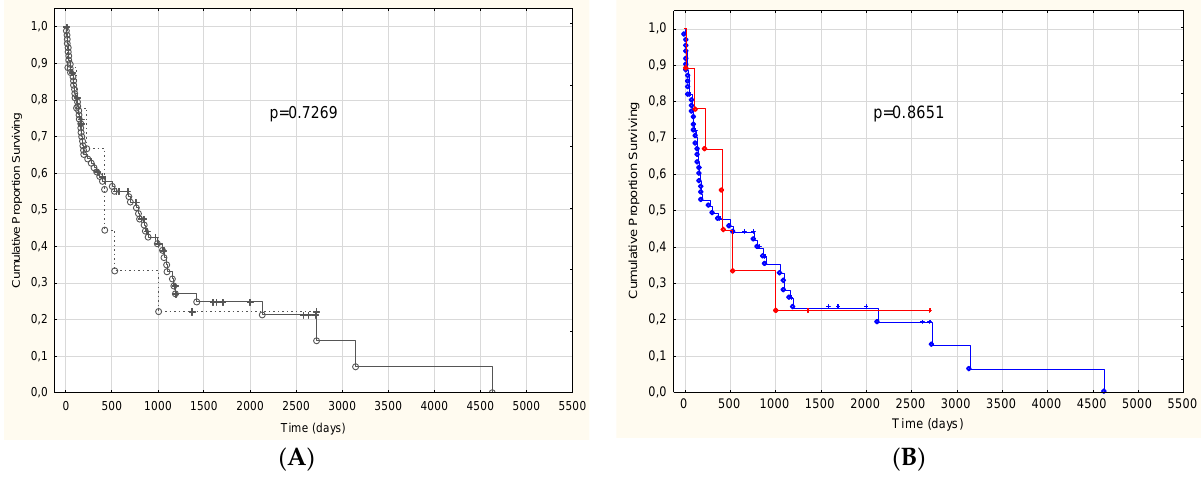
Figure 2. ( A ): Kaplan–Meier curves comparing cardiac amyloidosis patients with and without increased left ventricular wall thickness (IWT: n = 89, non IWT: 9; Log–Rank test: p = 0.7269 ( A ). ( B ): only AL patients (IWT: n = 61, non-IWT: = 9) are presented. There was also no significant difference in the outcome (Log-Rank test: p = 0.8651). Dash line represents non IWT patients, continuous line represents IWT patients.